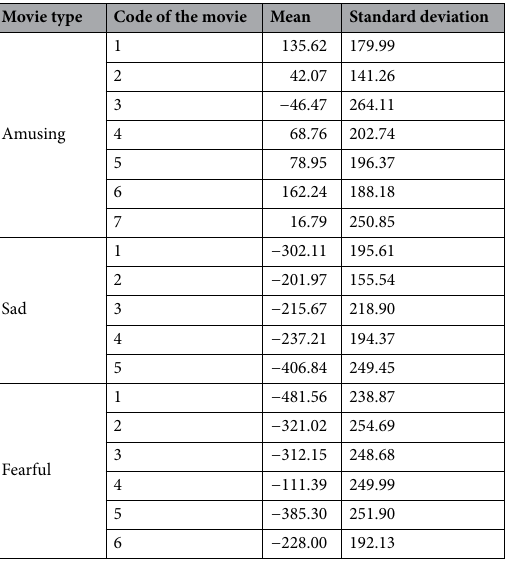
Table 2. Mean values of the behavioural valence ratings for each movie clip (ratings ranging from − 1000 to 1000 on an artificial scale). Amusing movie with code 3 was excluded from all the analysis due to negative mean value of the valence